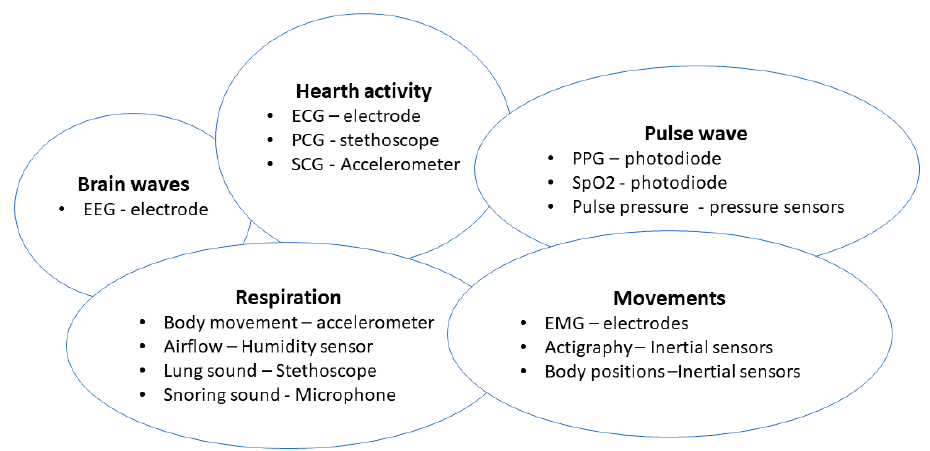
Figure 14. Classification of the most recent systems and applications for sleep monitor.